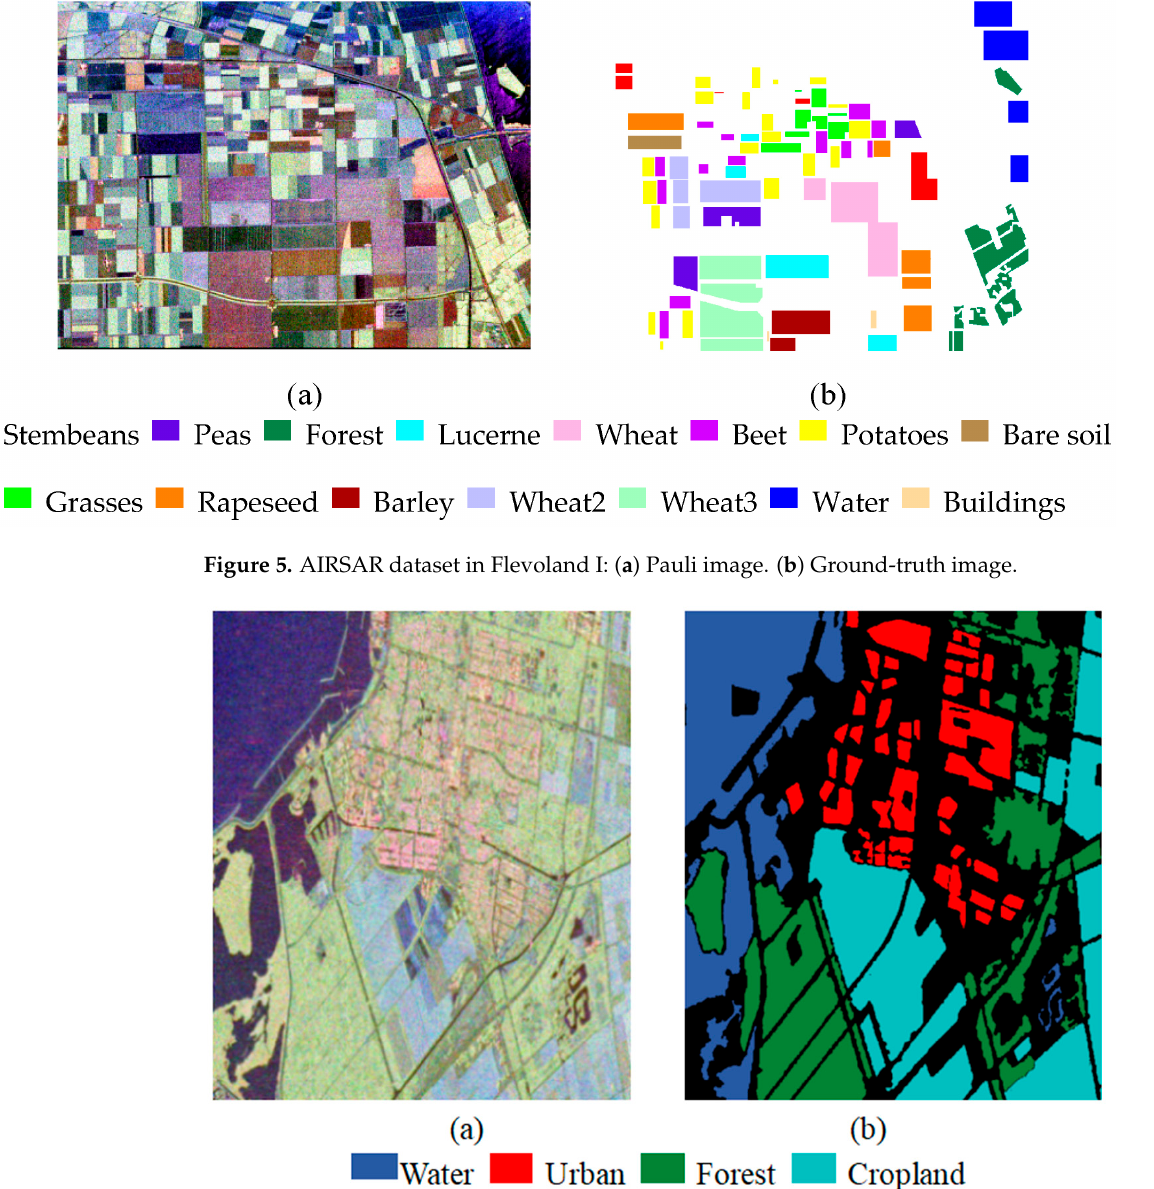
Figure 6. Flevoland II dataset: ( a ) Pauli image. ( b ) Ground-truth image. The third PolSAR dataset is C-band PolSAR data acquired by RADARSAT-2 in San Francisco in April 2008 with 1300 × 1300 pixels and a resolution of 10 m × 5 m . It contains 5 terrain objects: high-density, low-density, water, developed, and vegetation, and Figure 7a denotes the Pauli RGB map of this image. Figure 7b shows the appropriate ground-truth map of this image, and each type of crop is identified by one color. The fourth dataset is a C-band PolSAR data of China, Shaanxi, Xi’an, acquired by RADARSAT-2 in 2010, which has 512 × 512 pixels. The resolution of this image is 8 m × 8 m . It contains three different categories: bench land, urban, and river. The Pauli RGB map of the image is shown in Figure 8a, and the corresponding ground-truth map of this image is shown in Figure